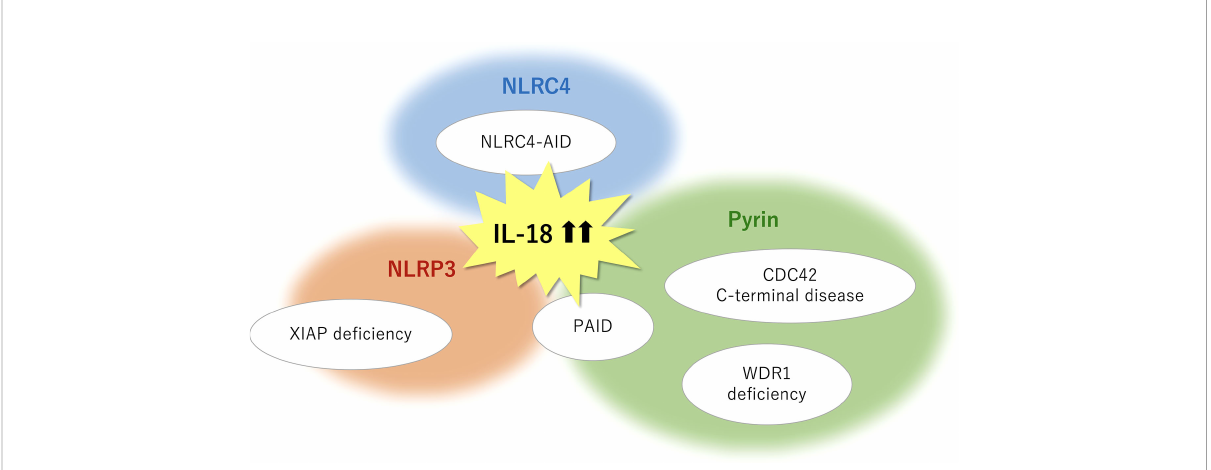
FIGURE 2 Monogenic SAIDs with chronic elevation of serum IL-18 and the relevant in fl ammasomes. NLRC4-AID is caused by gain-of-function mutations in the NLRC4 gene and is characterized by a high incidence of macrophage activation syndrome. The chronic nature of IL-18 elevation observed in XIAP de fi ciency primarily depends on the NLRP3 in fl ammasome, whereas an in fl ammasome-independent pathway may in part have a role in mature IL-18 overproduction. Pyrin in fl ammasome is associated with IL-18-mediated autoin fl ammation in actin remodeling defects such as CDC42 C-terminal disease, PSTPIP1-associated in fl ammatory diseases (PAID), and WDR1 de fi ciency. Pyrin may serve as a sensor for actin-cytoskeleton dynamics. NLRP3 involvement is also observed in several subtypes of PAID such as PAPA syndrome and PAMI syndrome. SAIDs, systemic autoin fl ammatory diseases; CDC42, cell division cycle 42; IL, interleukin; NLRC4-AID, NLR family caspase activation and recruitment domain-containing protein 4-associated autoin fl ammatory disease; NLRP3, NLR family pyrin domain containing 3; PAMI, PSTPIP1- associated myeloid-related proteinemia in fl ammatory; PAPA, pyogenic sterile arthritis, pyoderma gangrenosum, and acne; PSTPIP1, proline- serine-threonine phosphatase-interacting protein 1; WDR1, WD repeat-containing domain 1; XIAP, X-linked inhibitor of